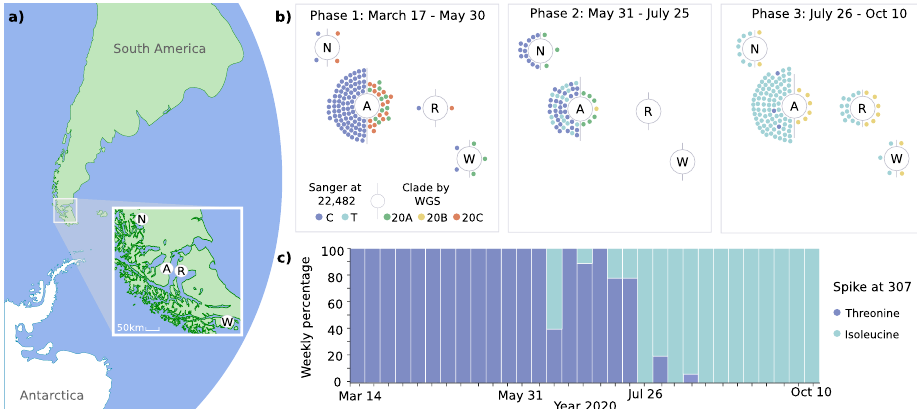
Figure 2. Geodynamic evolution of clades and spike 307 mutation. ( a ) Shows the geolocation of study sites in the Magallanes Region in Chile’s extreme south (N, Puerto Natales; A, Punta Arenas; R, Porvenir; W, Puerto Williams). ( b ) Demonstrates the distribution of mutations of spike protein at genomic position 22,482 and clades (Nextstrain classification) at the four study sites. Colored dots represent individual cases analyzed by targeted sequencing and whole genome sequencing